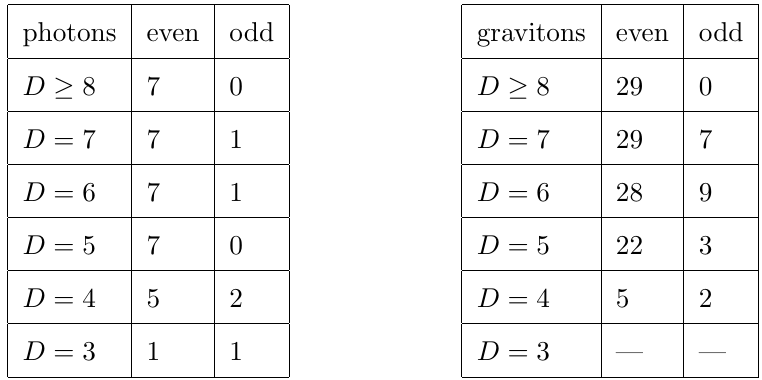
Table 3 . Number of parity even and parity odd index structures for 4-photon and 4-graviton S-matrix as various